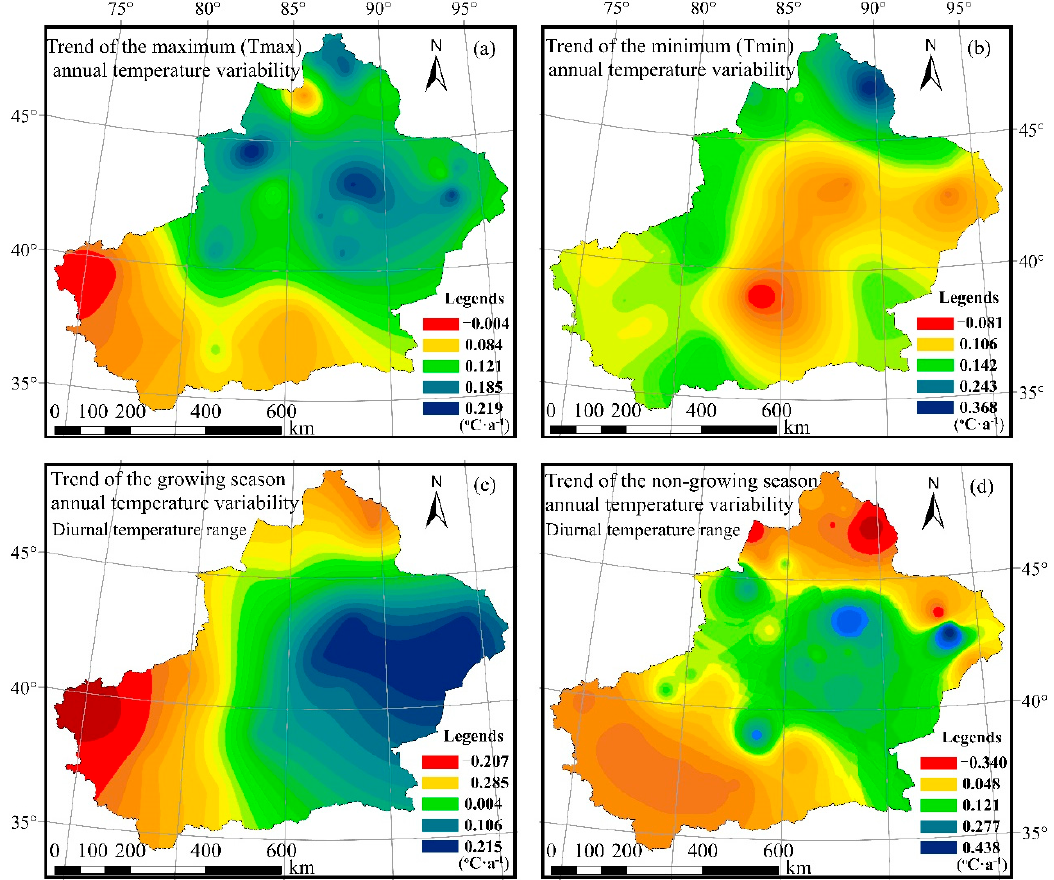
Figure 5. The spatial distribution of averaged T max and T min over 20 years in the arid and semiarid region, ( a ): the trend of T max , ( b ): the trend of T min , ( c ): diurnal range in the growing season of vegetations, ( d ): diurnal range in the non-growing season of vegetations. S1 and S2 represent two regions of the study area.